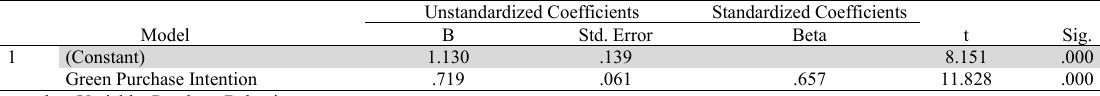
Multiple Regression Analysis